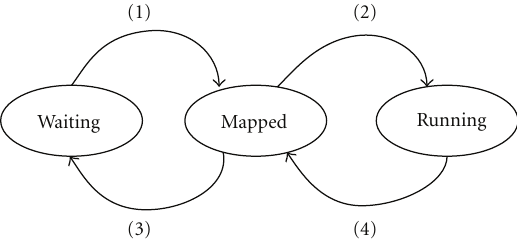
Figure 1: A finite-state machine (FSM) showing the di ff erent states of a